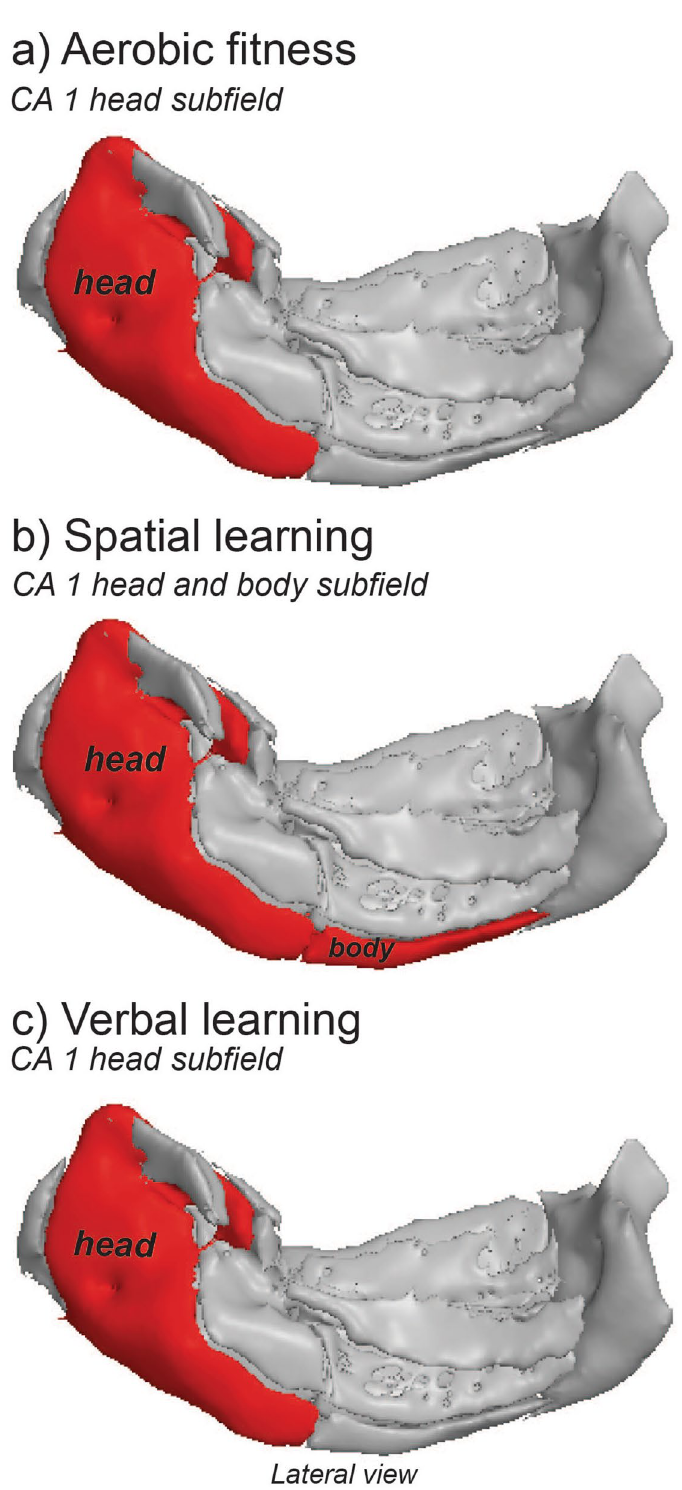
Figure 3. Hippocampal subfields associated with exercise and cognitive domains. A 3-D representation of the positive associations between IV variables of interest: ( a ) aerobic fitness, ( b ) spatial learning, and ( c ) verbal learning with CA1 subfields. Positive associations correspond to larger volumes within the CA1 subfield. Hippocampal images were created using Quantitative Imaging Toolkit (QIT) 143